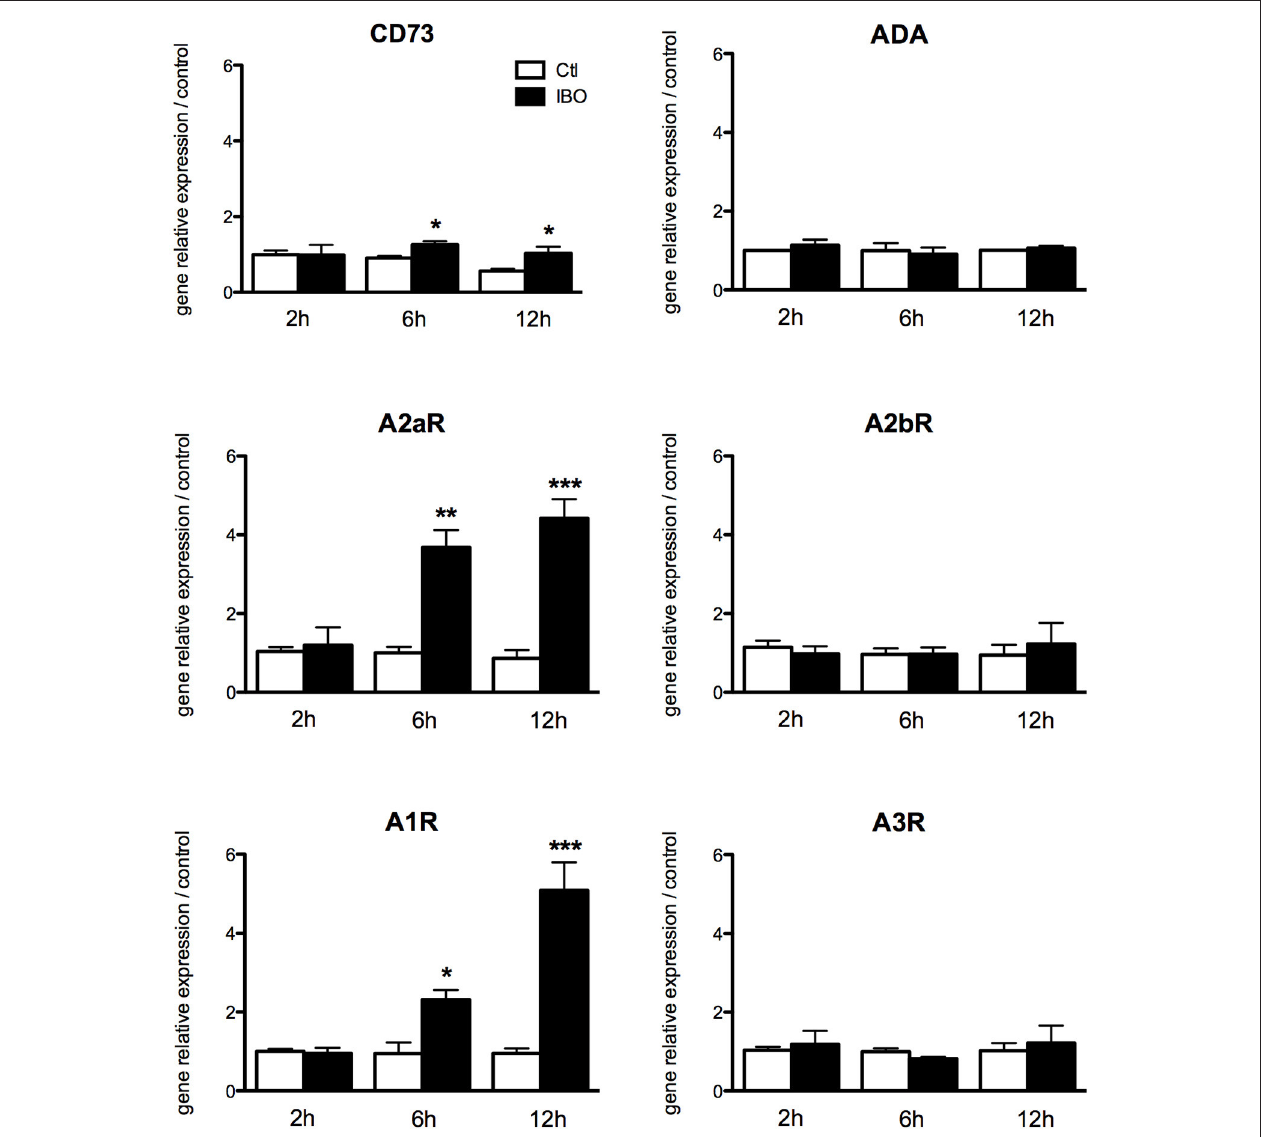
FIGURE 6 | Effect of ibotenate exposure to microglial cell cultures on gene expression of enzymes involved in the production of adenosine and its receptors. Data are shown as relative expression of control values (PBS exposure) set to 1 for each time-point. (* p < 0.05, ** p < 0.01, *** p < 0.001, using unpaired Student’s t -test). CD73, cluster of differentiation 73; A2aR, adenosine A2a receptor; A1R, adenosine A1 receptor; ADA, adenosine deaminase; A2bR, adenosine A2b receptor; A3R, adenosine A3